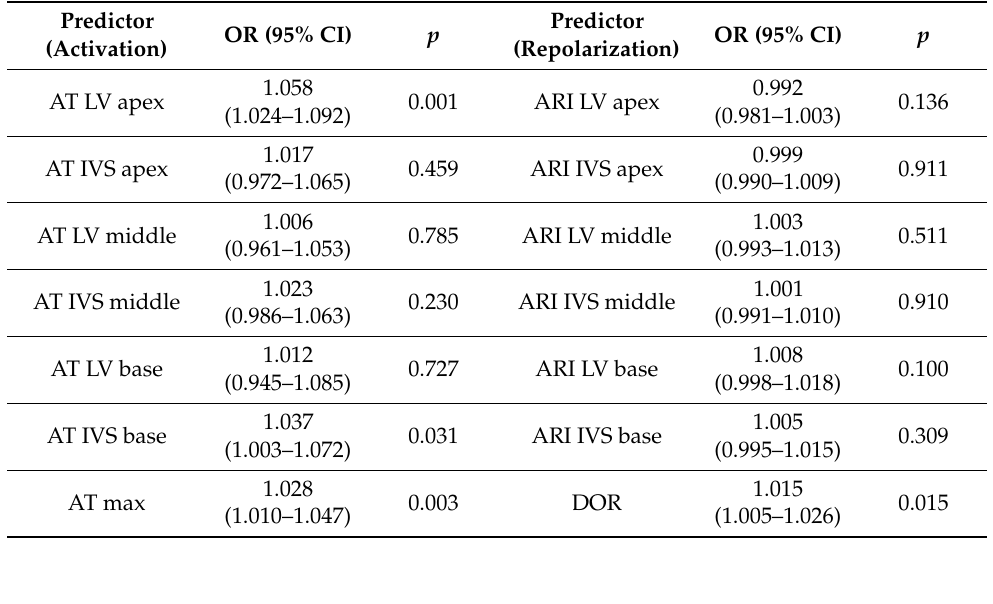
Table 1. Association of VF incidence with activation and repolarization parameters (univariate logistic regression analysis).